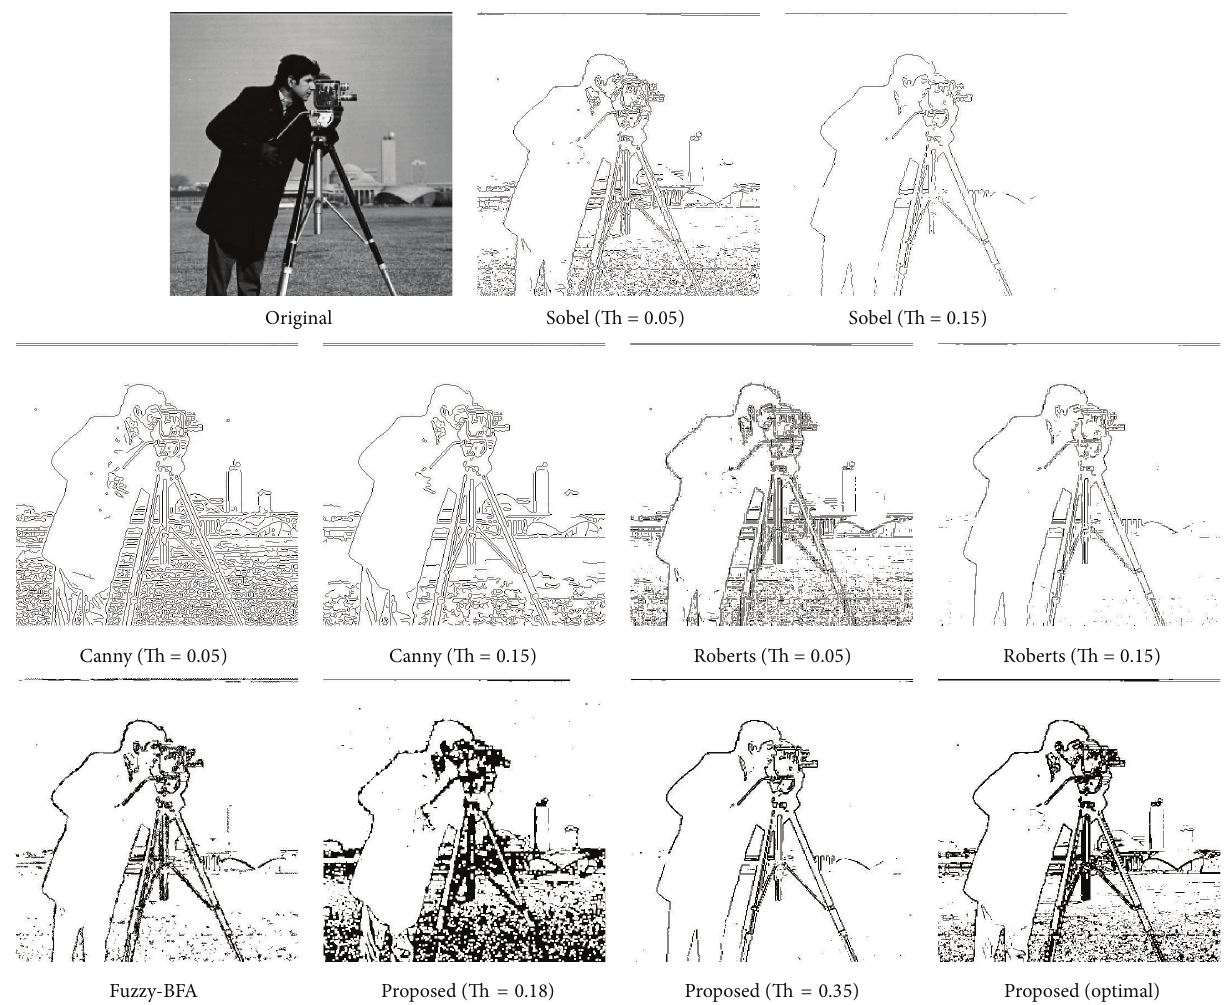
Figure 12: Edge detection results of “cameraman” image: Sobel, Canny’s, and Roberts methods using thresholds = 0.05 and 0.15; fuzzy-BFA method; proposed method with fixed thresholds (0.18 and 0.35) and optimal